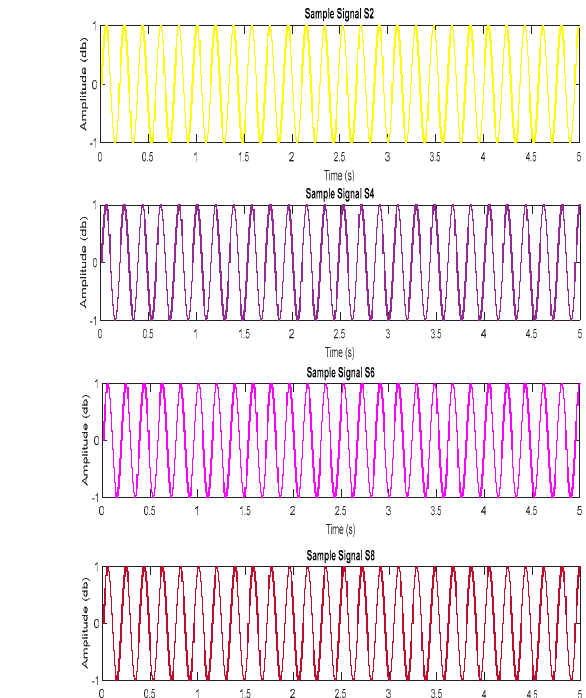
( b ) Figure 5. ( a ) Targeted RF points ( b ) RFID tag deployment on subject. In order to begin the process of data collection, eight RFID transceivers are used to